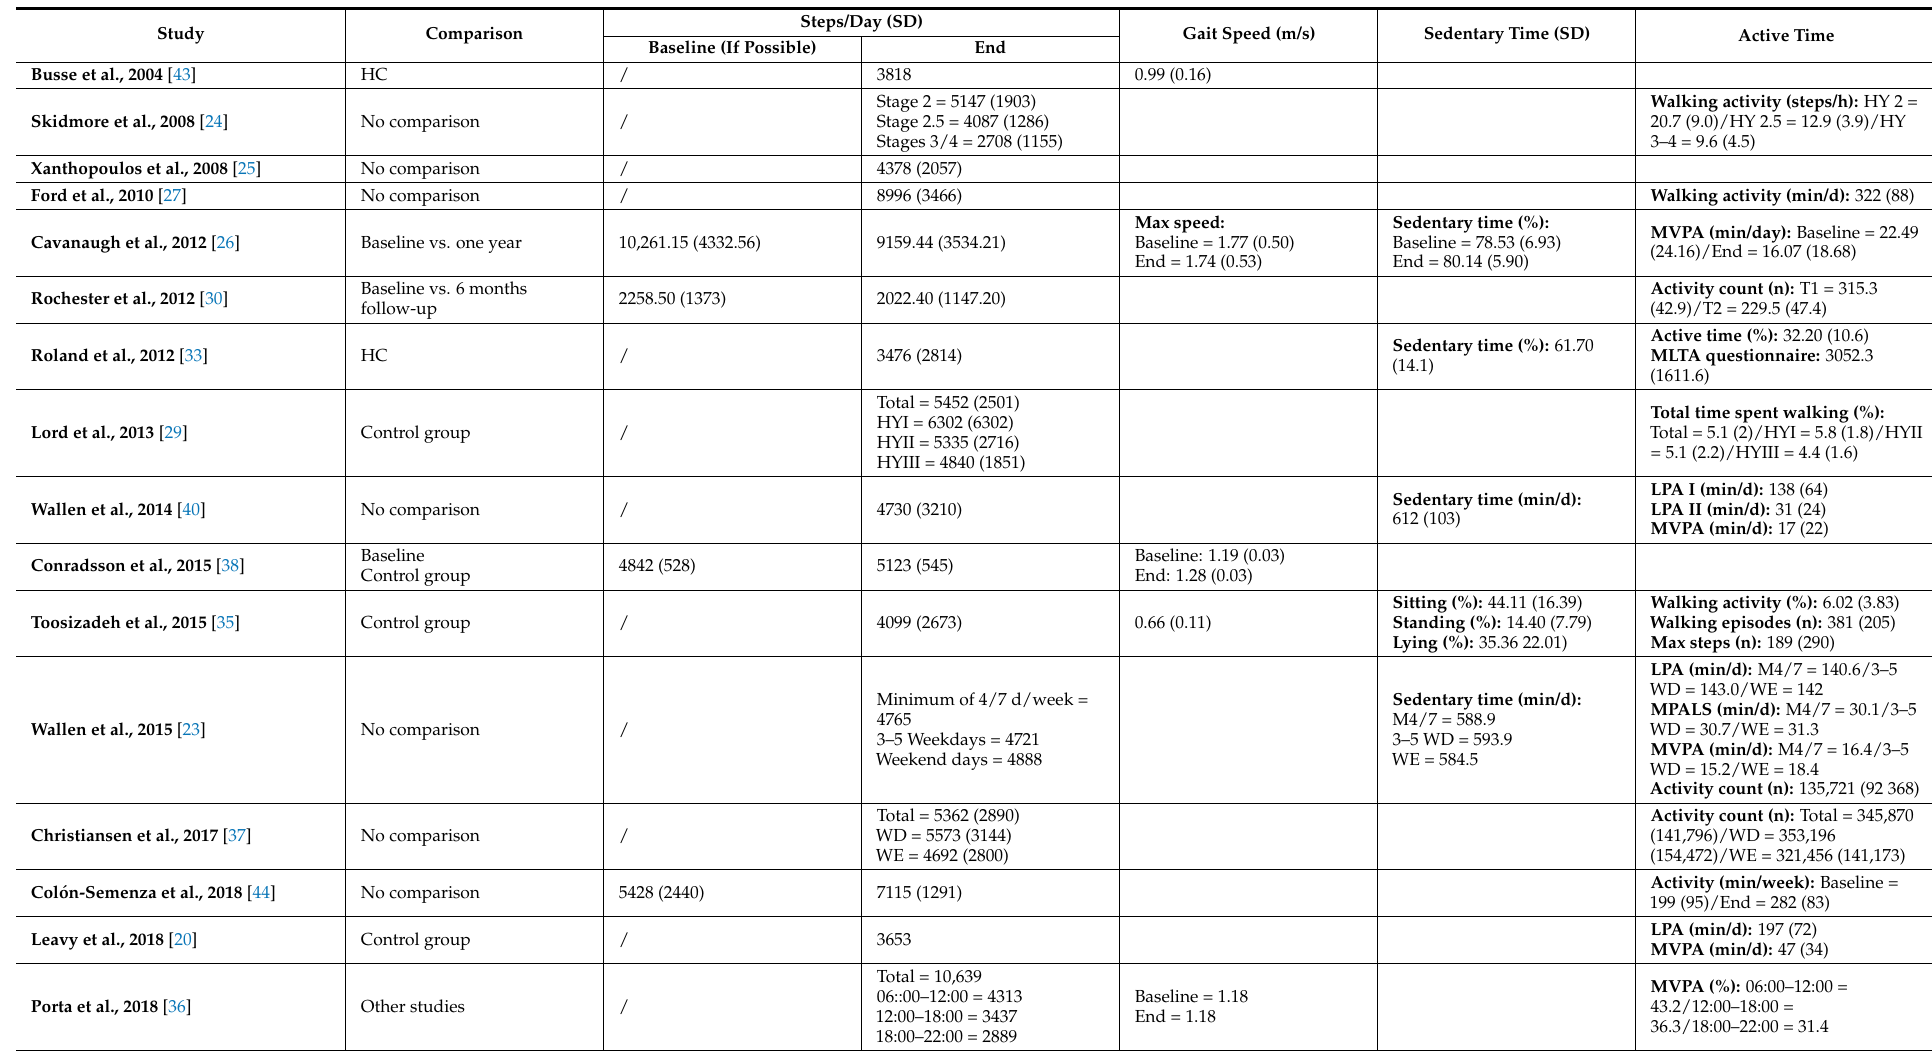
Table A4. Main outcomes of the included